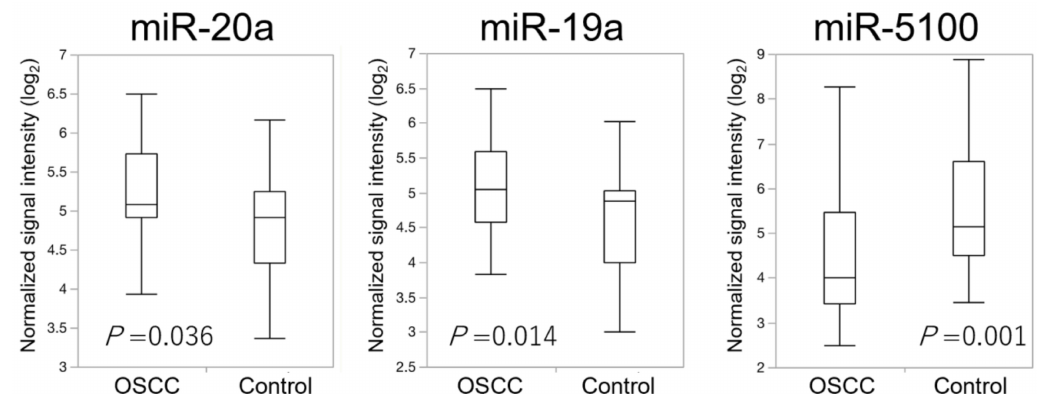
Figure 3. Comparison of normalized signal intensities of three microRNAs in oral squamous cell carcinoma (OSCC) patients and the control group. Signal intensities of three microRNAs, miR-20a, miR-19a, and miR-5100, were significantly different (Wilcoxon test, p < 0.05). Relative expression levels were significantly increased in miR-19a and miR-20a of OSCC patients, whereas miR-5100 of the control group showed a higher intensity.